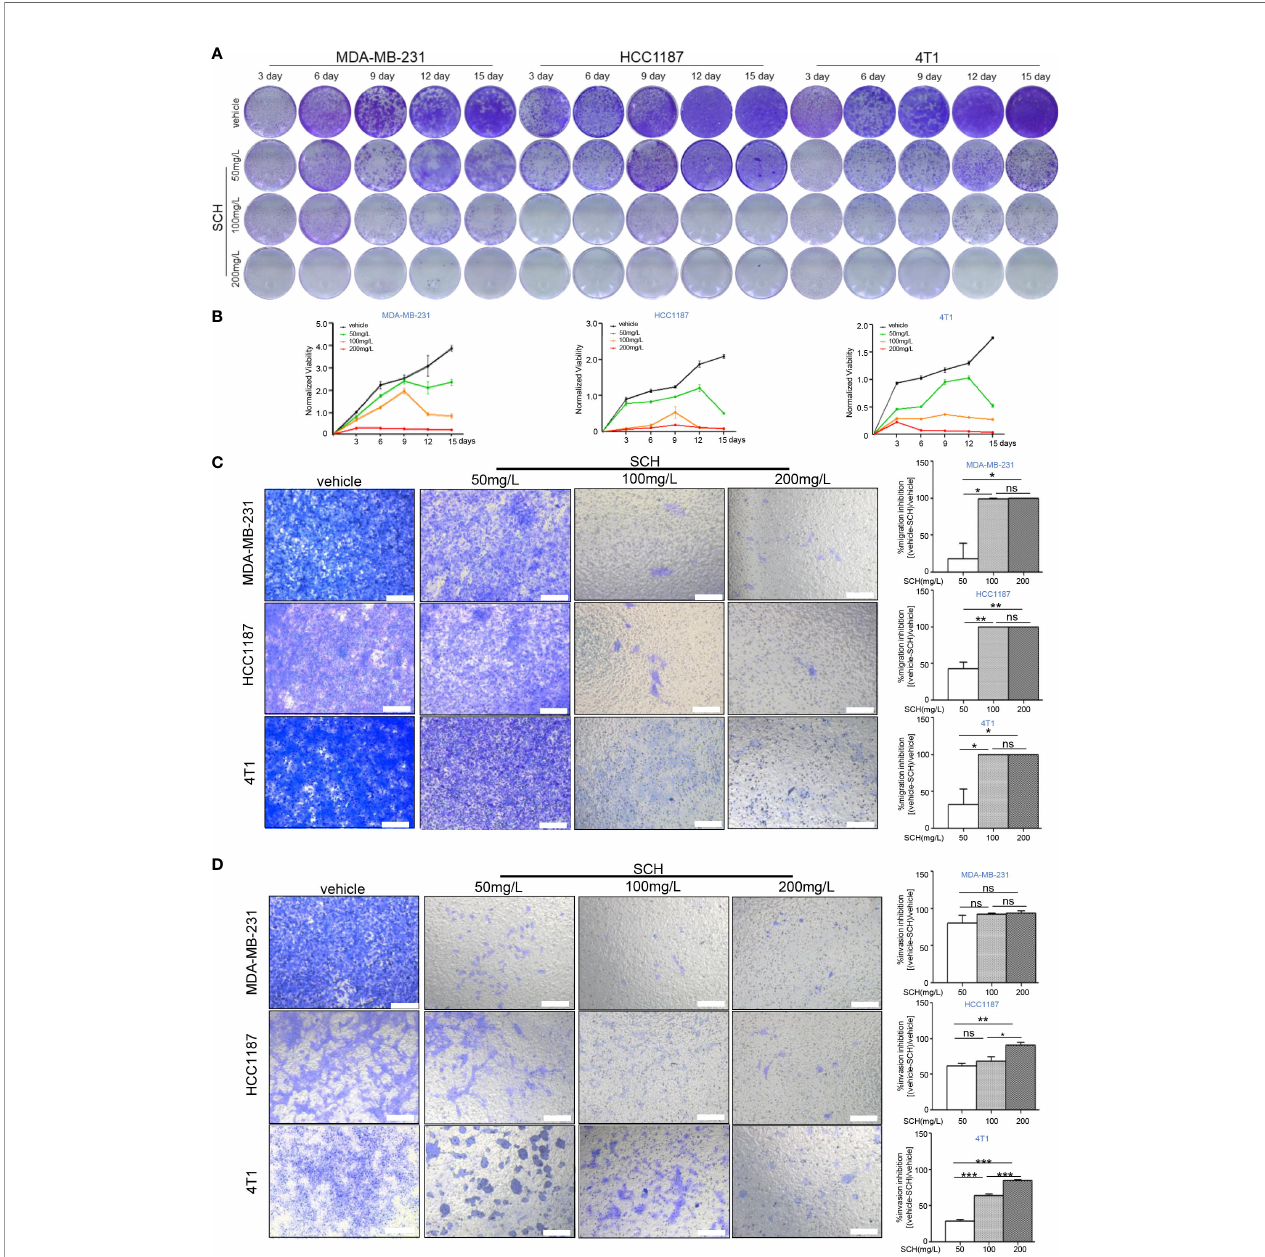
FIGURE 1 | SCH inhibits TNBC cell growth, migration, and invasion. (A) TNBC cells were cultured with varying dosages of SCH for 3, 6, 9, 12, and 15 days and stained via crystal violet (media were replenished every third day). (B) The quanti fi cation of the clonogenic survival assay is shown as mean ± S.D. from three independent experiments. Representative images of the migration (C) and invasion (D) after SCH treatment. Scale bar, 100 µm. Results exhibited as mean ± S.D. from three separate trials. “ ns ” , not signi fi cant, *P < 0.05, **P < 0.01, ***P < 0.001 (Student ’ s t